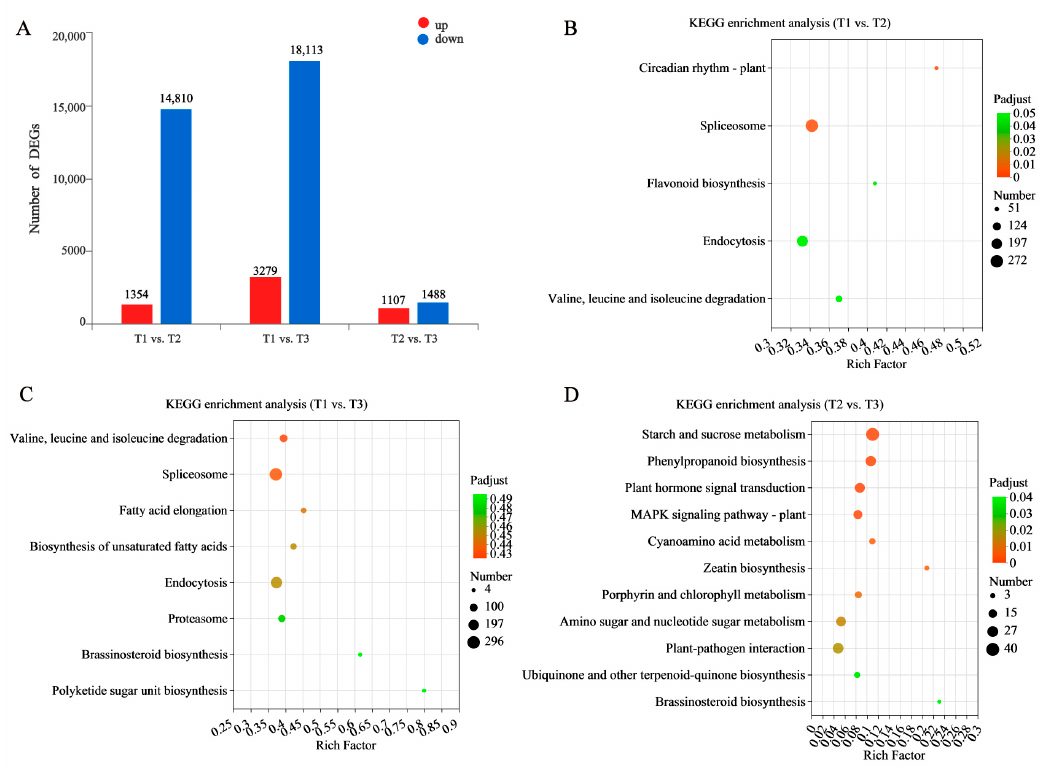
Figure 4. Significant DEGs analysis in three groups. ( A ) the number of DEGs. Red represents up-regulated DEGs, and blue represents down-regulated DEGs. KEGG analysis of the DEGs in ( B ) T1 vs. T2, ( C ) T1 vs. T3, ( D ) T2 vs. T3. The x-axis represents the richness factor, and the y-axis shows KEGG pathways. The color and size of the dots represent the p -value and the number of enriched DEGs, respectively. Rich factor means the ratio of the number of DEGs to the total number of genes enriched in a specific category.